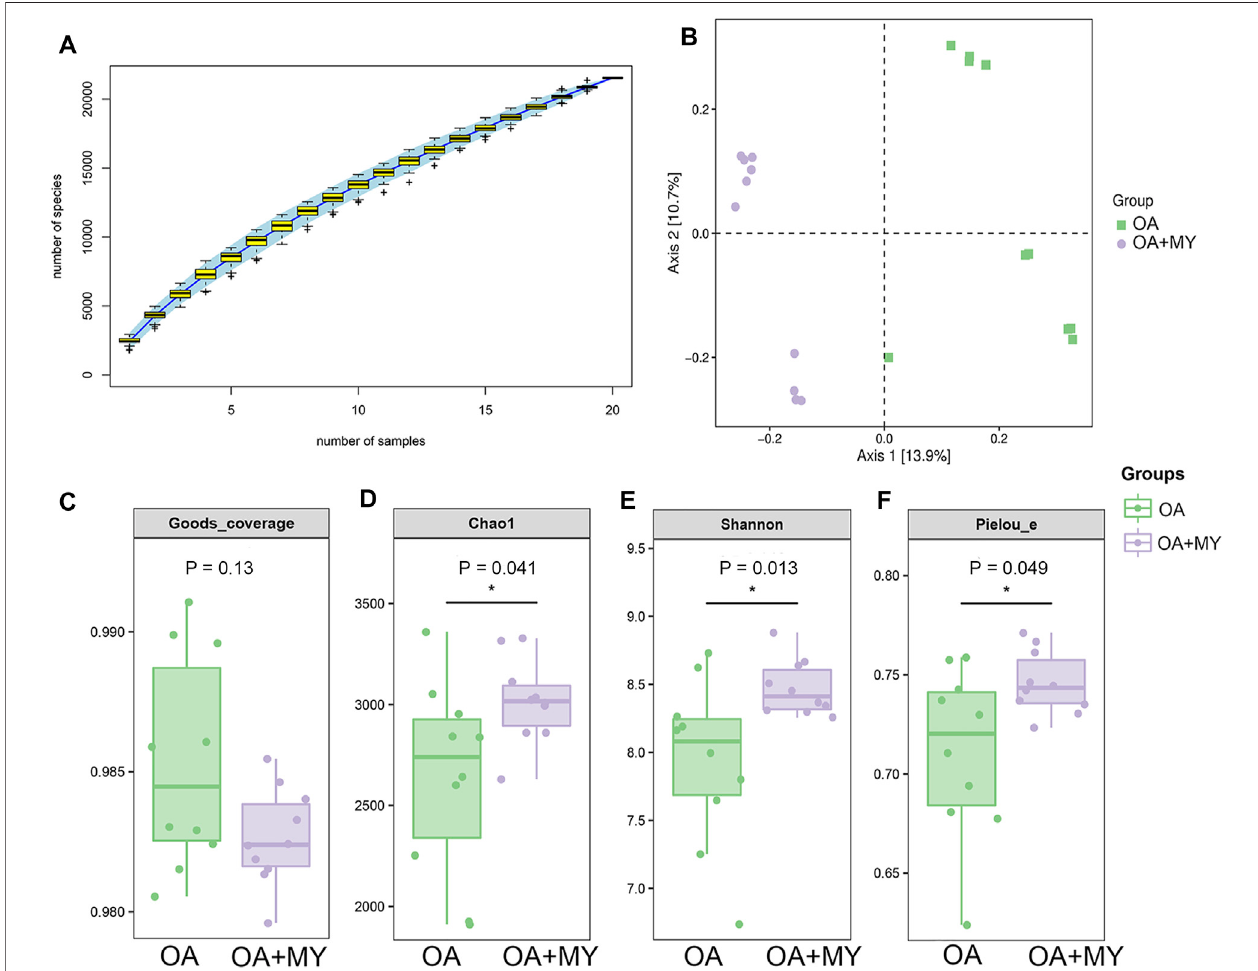
FIGURE 2 | Effects of MY on the overall diversity of gut microbiota in OA. (A) Species accumulation curves analysis. (B) Beta diversity analysis using pincipal coordinate analysis (PCoA) based on the Jaccard distance. Alpha diversity analyses based on the Goods-coverage (C) , Chao1 index (D) , and Shannon index (E) , and Pielou ’ s evenness (F) . * p < 0.05, compared with the OA